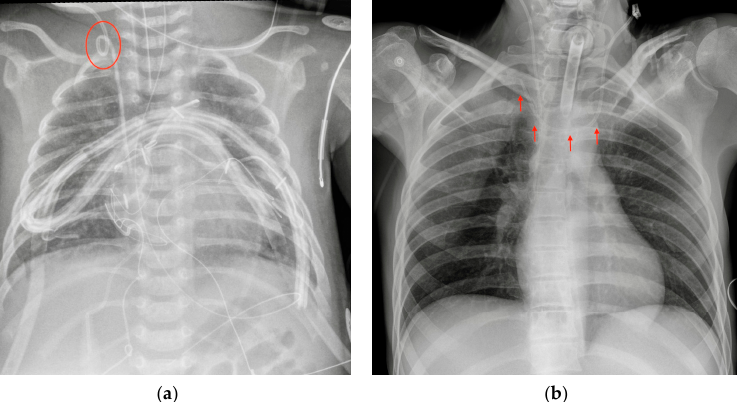
Figure 4. Malpositioned CVCs. ( a ) Right jugular-inserted CVC looping against the vessel wall and ending inside the SVC (red circle). ( b ) Left jugular CVC with tip ending inside the right subclavian vein (red arrows).